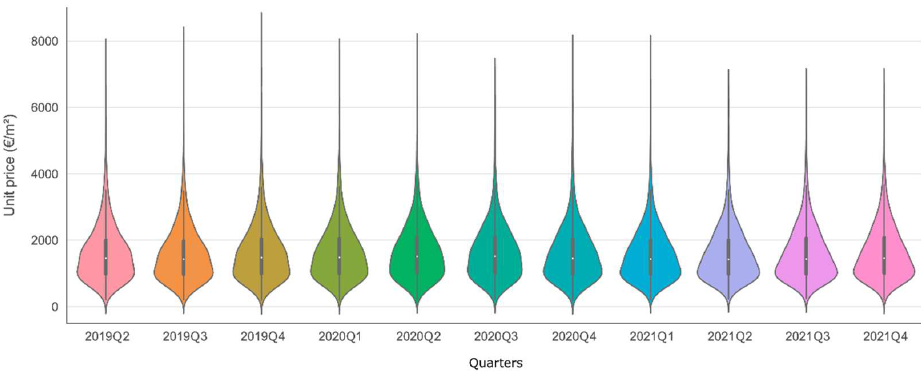
Figure 7. Violin chart with the distribution of the unit price (€/m²), according to each quarter analyzed.